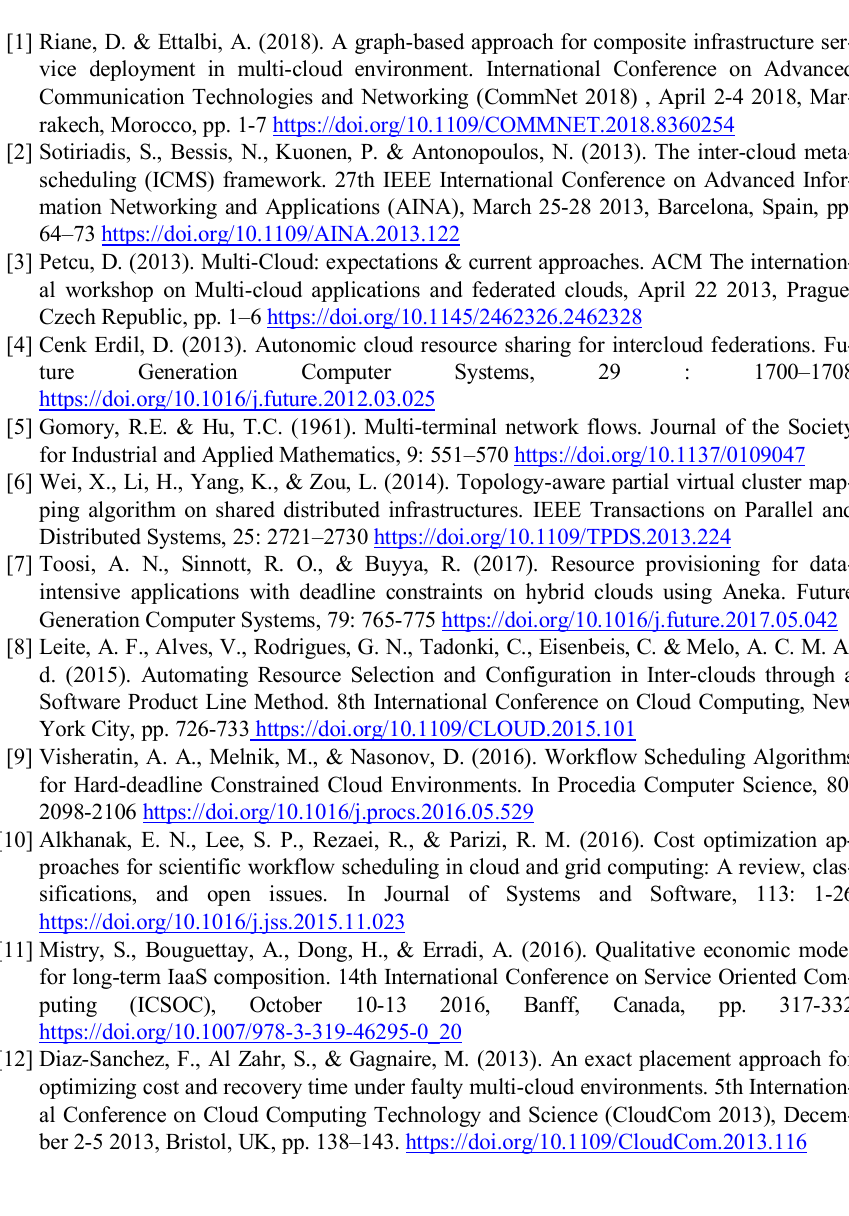
Paper —Efficient and Optimal Service Component Distribution across Multiple